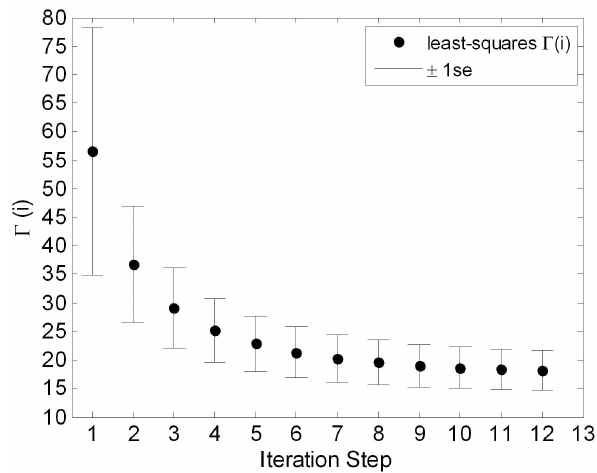
Fig. A2. Convergence of 0(i) as a function of iteration step. Val- ues of A and B were calculated at 5.4nm geometric diameter for the time period 12:40–13:00 during an NPF event observed on 19 September 2010 in Boulder, CO (NCAR). At each step, 0(i) and its corresponding standard error (1se) were obtained by a linear least- squares fitting method modified for regression through the origin with measurement uncertainties in both axes (Cantrell, 2008). Me- dian values of [H 2 SO 4 ] were used in this particular calculation (no systematic uncertainty applied).